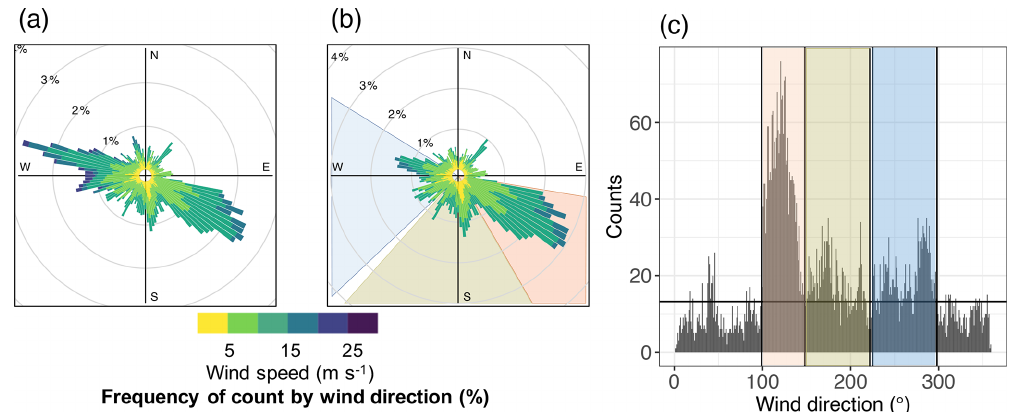
Figure 2. (a) Wind rose for the entire analysed PCAN voyage (6 February–4 March 2017). (b) Wind rose for wind measurements south of 56.5 ◦ S (excluding measurements from the homeward transit to Hobart, Tasmania, the transit category), showing selected sectors. There are three areas demonstrating a higher density of wind measurements, from the WNW (Ferrel, sector: 225–298 ◦ , width 73 ◦ ), from the SE (polar, sector 99–148 ◦ , width 49 ◦ ), and from the S (southerly, 148–217 ◦ , width 69 ◦ ). These sectors, capturing 76% of available wind measurements, are shaded in blue (Ferrel, 22%), khaki (southerly, 20%), and orange (polar, 34%) respectively. (c) Frequency histogram of wind measurements plotted in 2b with 1 ◦ bin size. Ferrel (blue), southerly (khaki), and polar (orange) sectors are